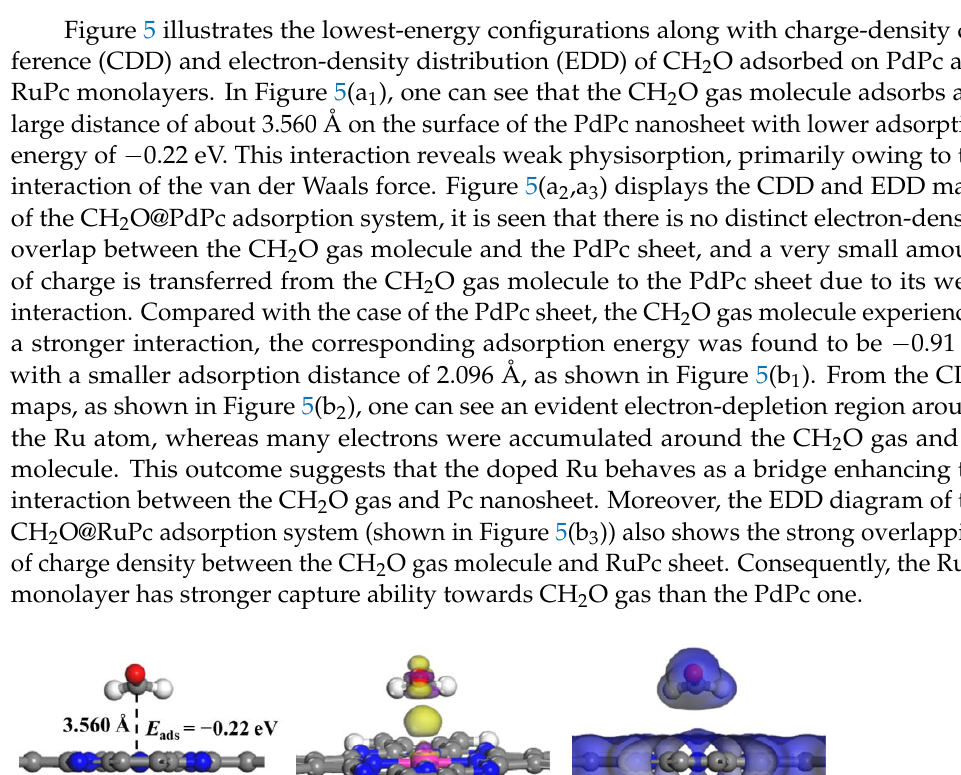
Figure 6. The density of states (DOSs) and partial density of states (PDOSs) of CH 2 O@PdPc and CH 2 O@RuPc adsorption systems. ( a,b ) DOSs map before and after CH 2 O adsorption on PdPc and RuPc, and ( c,d ) PDOSs of O, Pd, and Ru atoms. The Fermi level is set to zero energy and indicated by the purple dashed line.